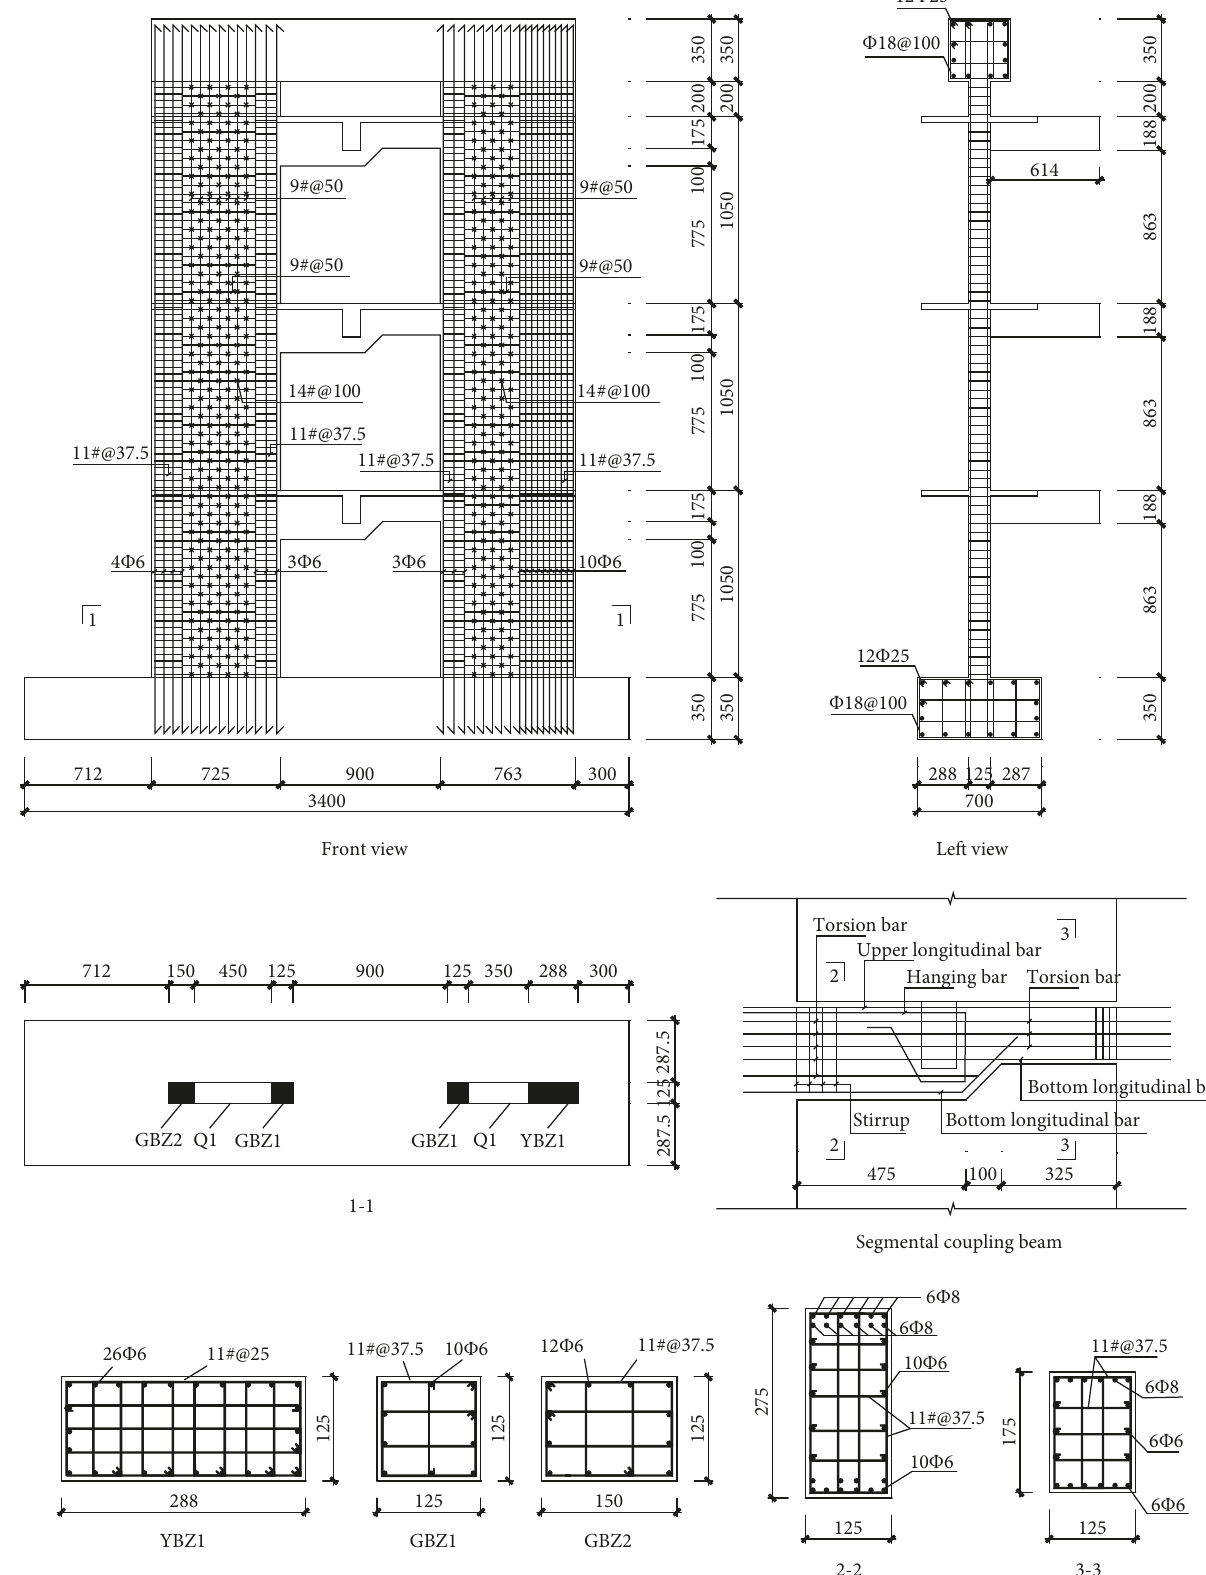
Figure 3: Dimensions and reinforcement details of the specimen (length unit: